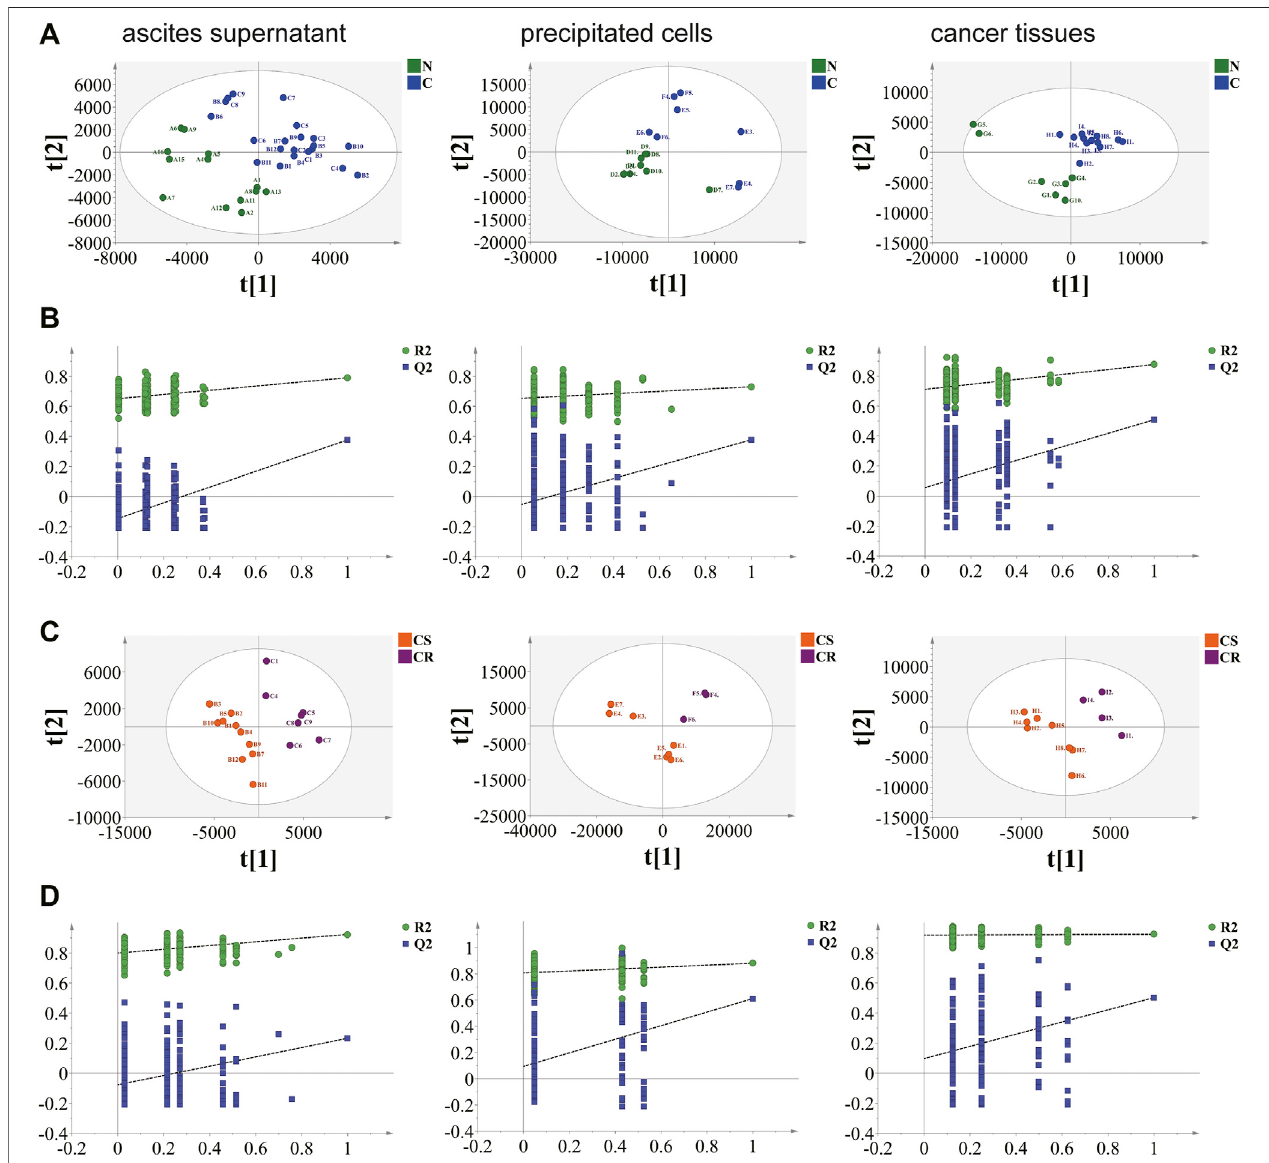
FIGURE 1 | Results of supervised partial least squares discriminant analysis (PLS-DA) and permutation test. (A) , (B) non-chemotherapy group and chemotherapy group. (C) , (D) chemotherapy-sensitivity group and chemotherapy-resistant group. Ovarian cancer ascites supernatant, precipitated cells and tissue samples can be separated. The permutation test indicates that the PLS-DA model of tissue data set is not over- fi tting.